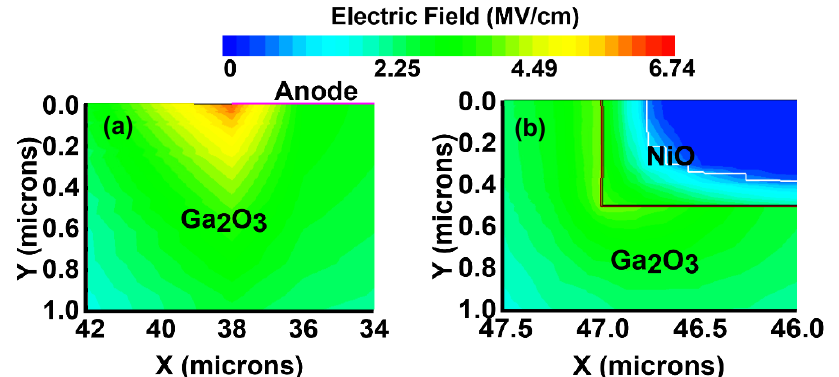
Figure 6. Electric field distribution in SBD with ( a ) no GR ( b ) GR at a reverse bias voltage of 1000 V. The doping concentration of the NiO is 1 × 10 18 cm − 3 , the width of GR is 42 μ m, and the drift layer thicknesses is set to be 10 μ m.